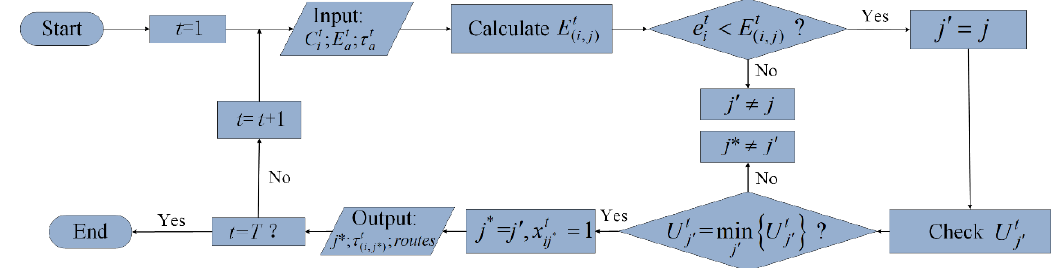
Figure 3. Flowchart of the charging station balance (CSB) strategy.